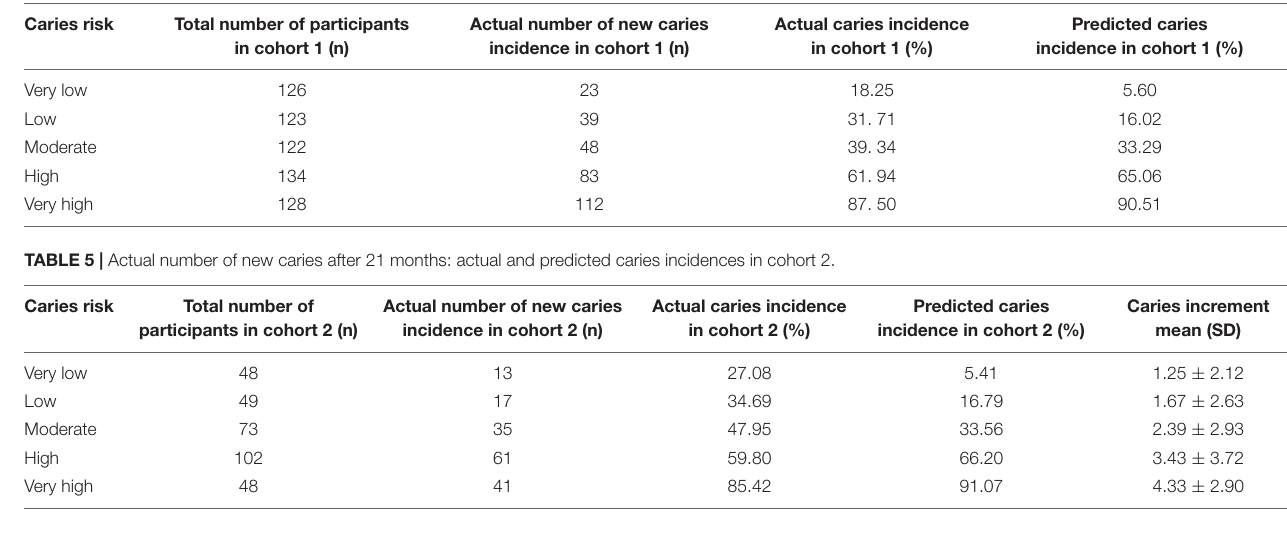
TABLE 4 | Actual number of new caries after 21 months: actual and predicted caries incidences in cohort 1.